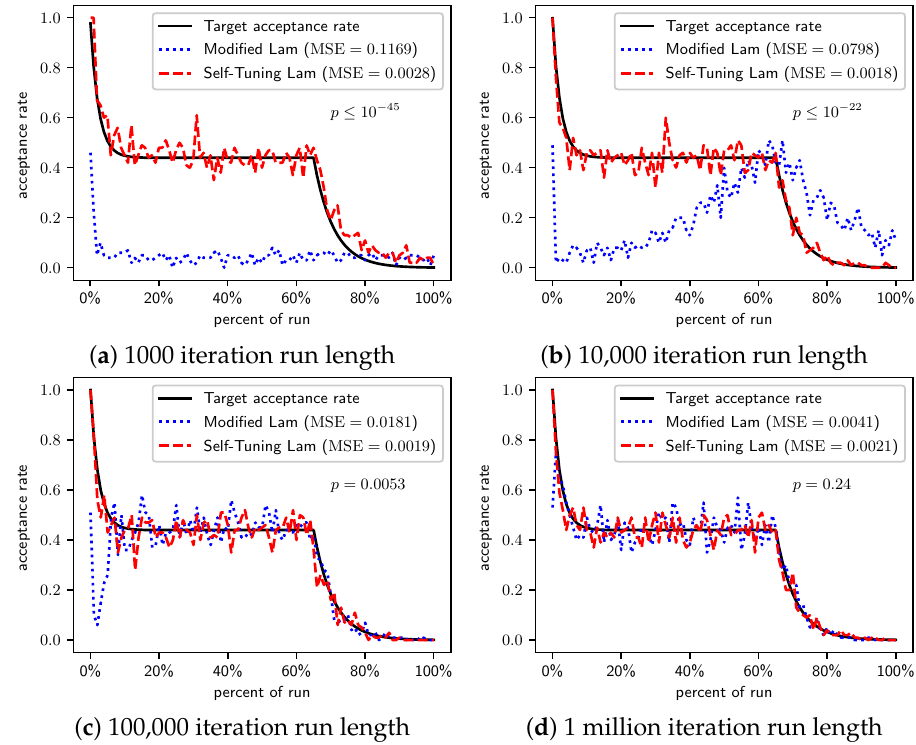
Figure 20. Minimize g 1000 ( x ) : Self-Tuning Lam, Modified Lam, and target acceptance rates